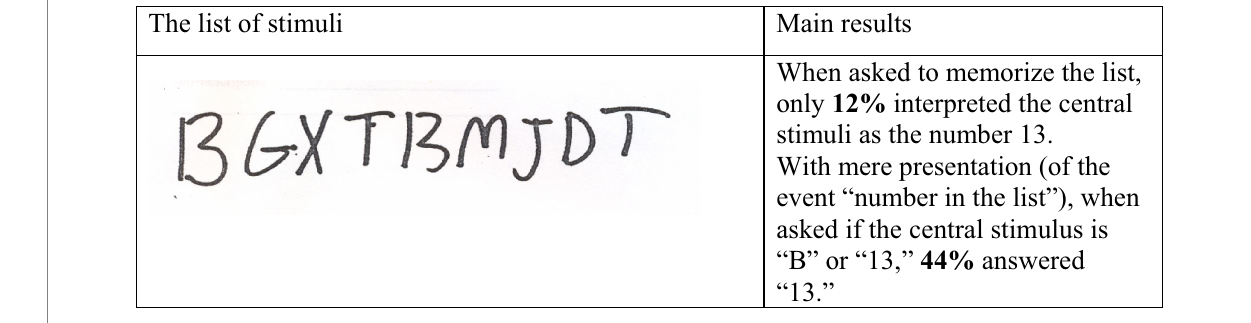
FIGURE 2 The list of stimuli used by Erev et al.